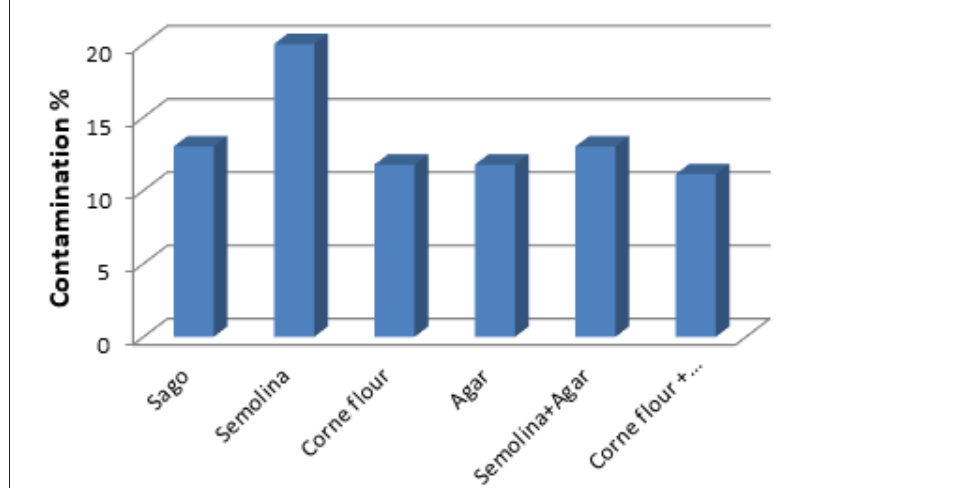
Figure 2. Contamination percentage of different gelling agent on MS